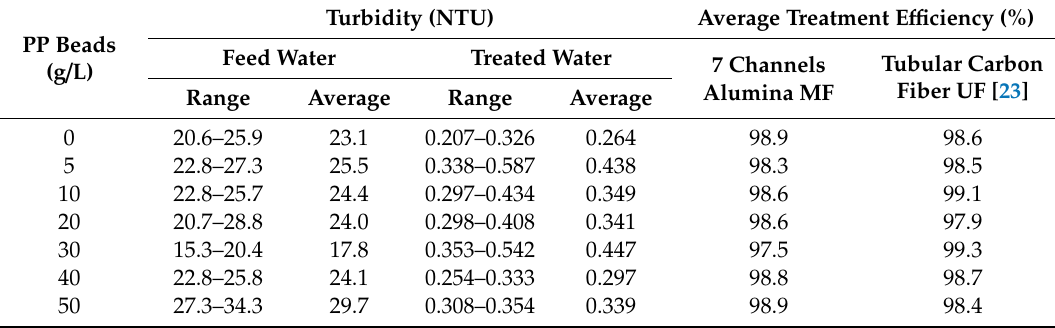
Table 6. Water quality and treatment e ffi ciency of turbidity in the hybrid process of 7-channel alumina MF (HC10) and PP beads for the e ff ect of PP beads concentration as compared with results of tubular carbon fiber UF (C005)